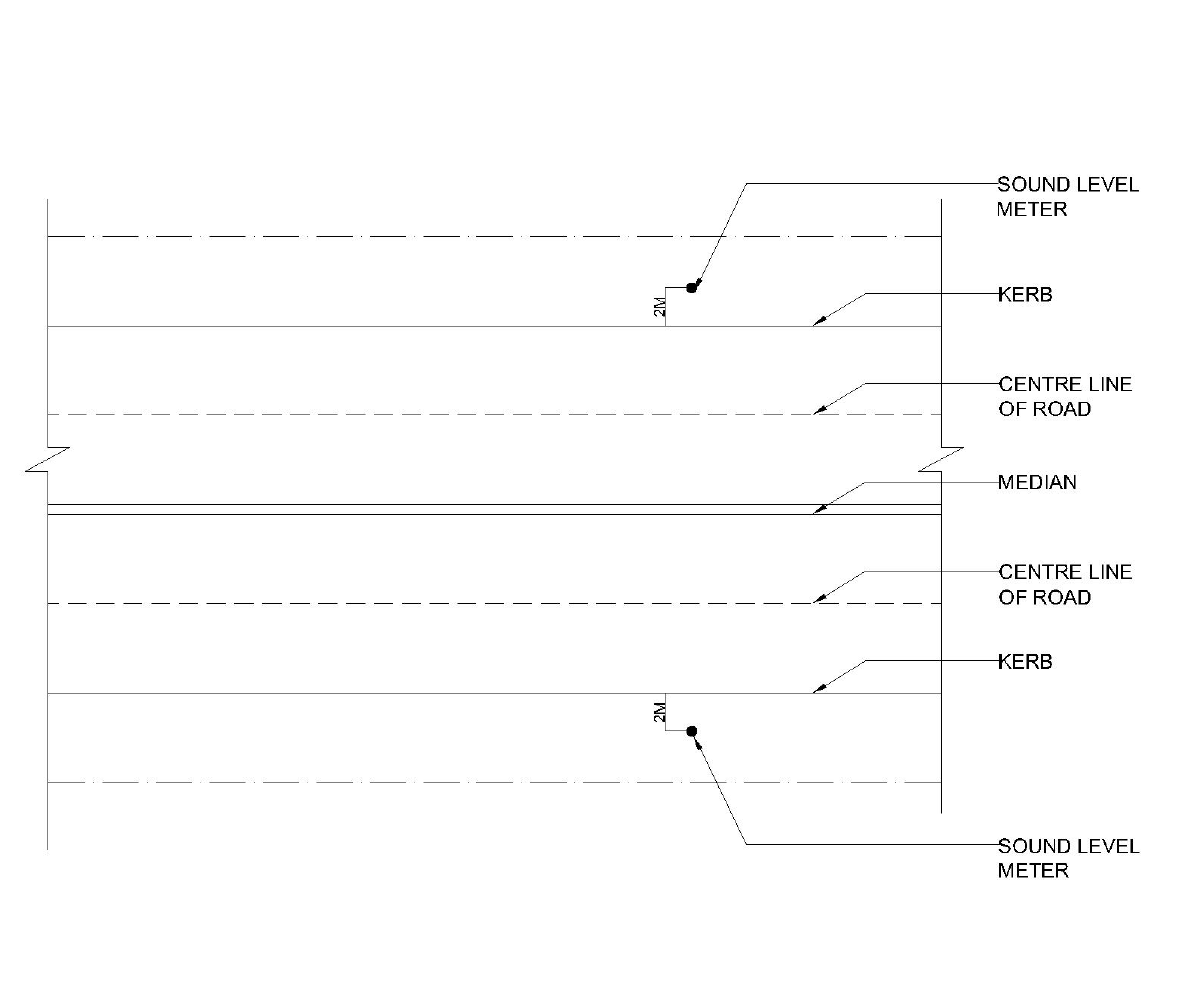
tinuous noise. The literature survey shows that the effect of noise barrier in the propagation of sound is missing in urbansettingsofdevelopingcountries,whichsignificantly affect the pattern of distribution of the noise levels. There- fore, the main objective of this paper is to investigate the effects of noise barrier in the propagation of sound using 3D noise